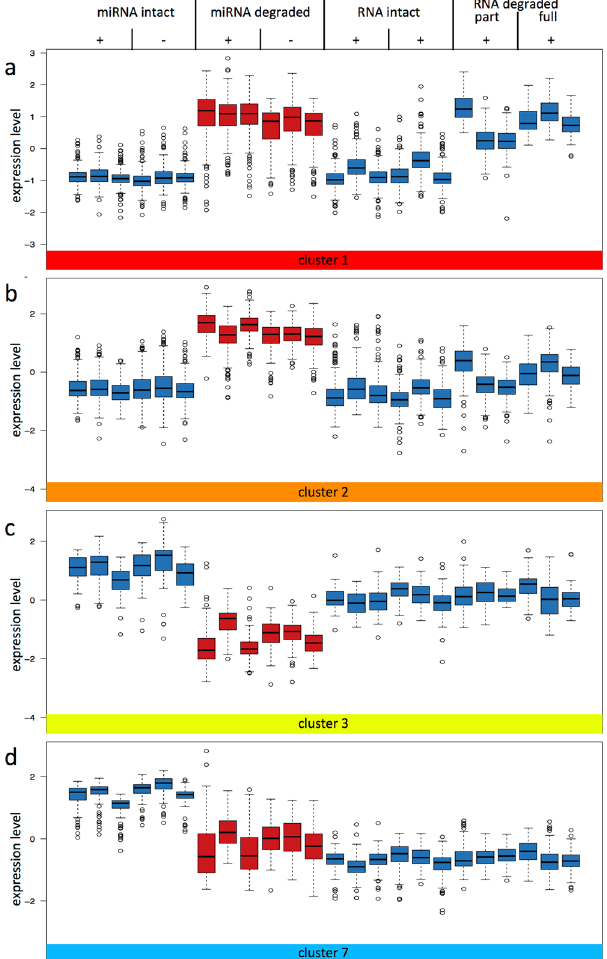
Figure 6. Expression of miRNAs in selected miRNA clusters. Box-plots of the median expression of miRNAs (Y axis) in liver tissues are shown for treatment/source of RNA as indicated above the box-plots (description is as in Fig. 5). The selected cluster is indicated by the same color code and number as in Fig. 5 as shown below the box-plots. Figure 6a shows cluster 1, 6b cluster 2, 6c cluster 3 and 6d cluster 7. Respective box-plots for the remaining clusters can be found in Supplementary Fig. S4. The list of miRNAs belonging to each cluster can be found in Supplementary Table